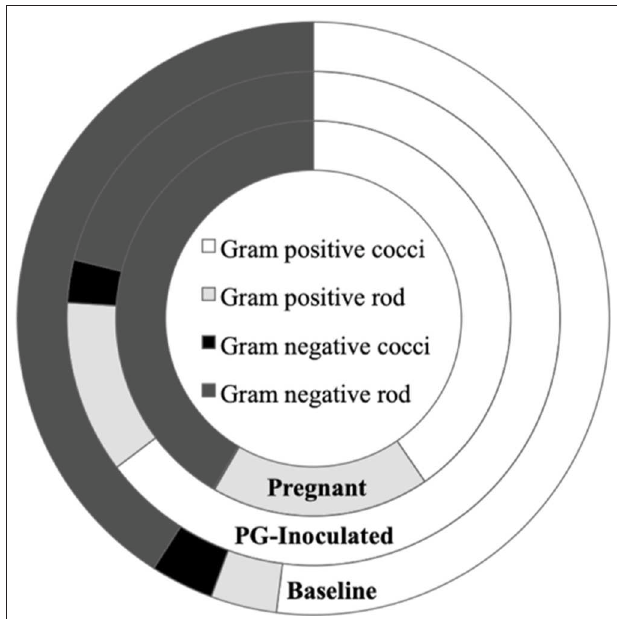
FIGURE 9 | Population proportion of identified community members in terms of predicted Gram stain classification and cell morphology for baseline, PG-inoculated, and pregnant